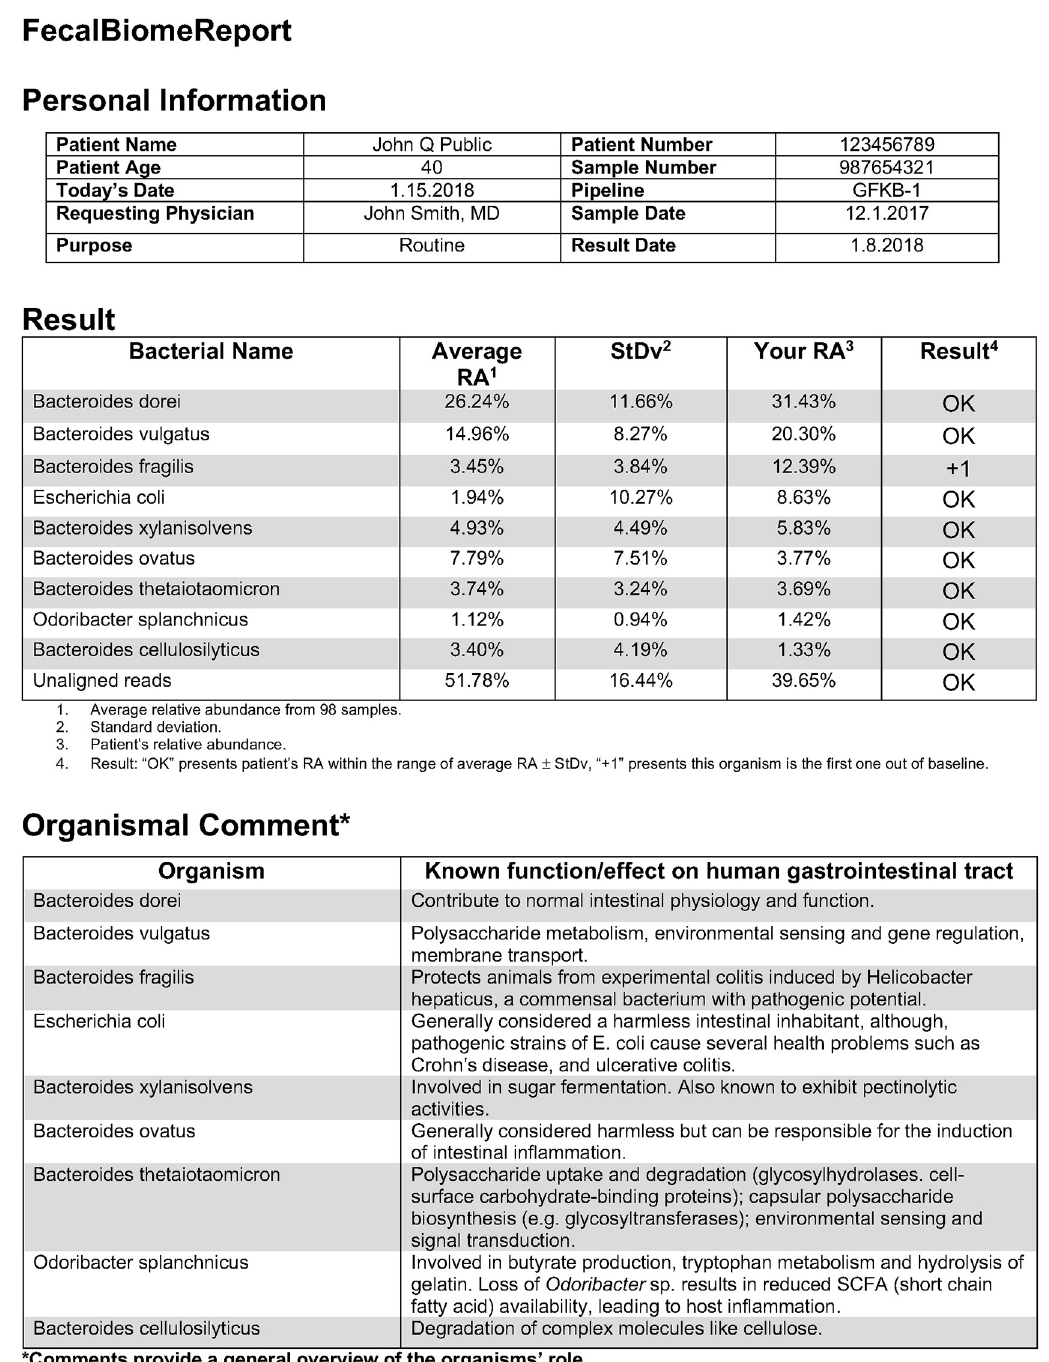
Fig 5. FecalBiome Reporting Template. Personal Information section of the report contains information about the individual who had a sample sequenced, as well as the individual who ordered the sequence. It contains information about the pipeline used for analysis, as well as the sample number for ease of retrieval. Result section contains microbes representing the most abundant organisms which comprise the top 50% of inhabitants. Organismal Comment section includes information from the GutFeelingKB which pertains to the potential function of that